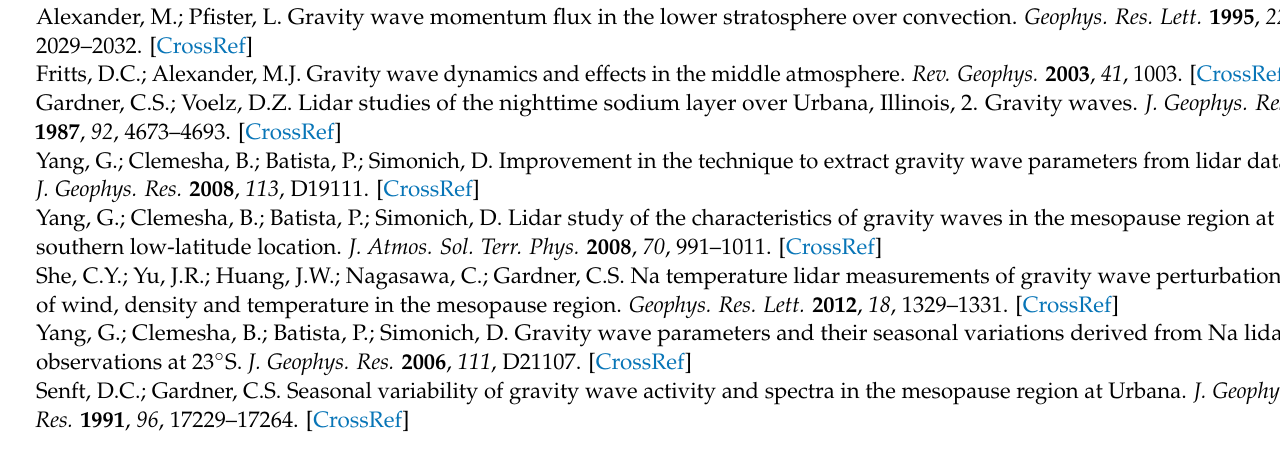
and Hainan; Figure S6: Selected Fa( ω ) and their fitting slope to the spectra of GW atmospheric density perturbations nightly at Beijing. The straight dotted lines are the regression fits to the spectra; Figure S7: Frequency spectra Vertical wave number power spectra of atmospheric density perturba- tions associated with gravity waves in the menopause region at Hefei; Figure S8: Frequency spectra of atmospheric density perturbations associated with gravity waves in the menopause region at Hainan; Figure S9: Annual averaged Fa( ω ) and their linear regression fits at Beijing, Hefei and Hainan. Figure S10: Distribution of fitting slopes of Fa( ω ) at Beijing, Hefei and Hainan in statistical seasonally